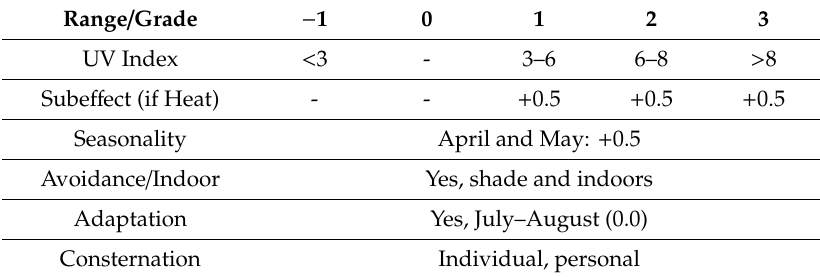
Figure 3. Range of exposition based on existing thresholds and limit values and no positive effects. Table 2. Factors affecting UV. Months refer to northern hemisphere.